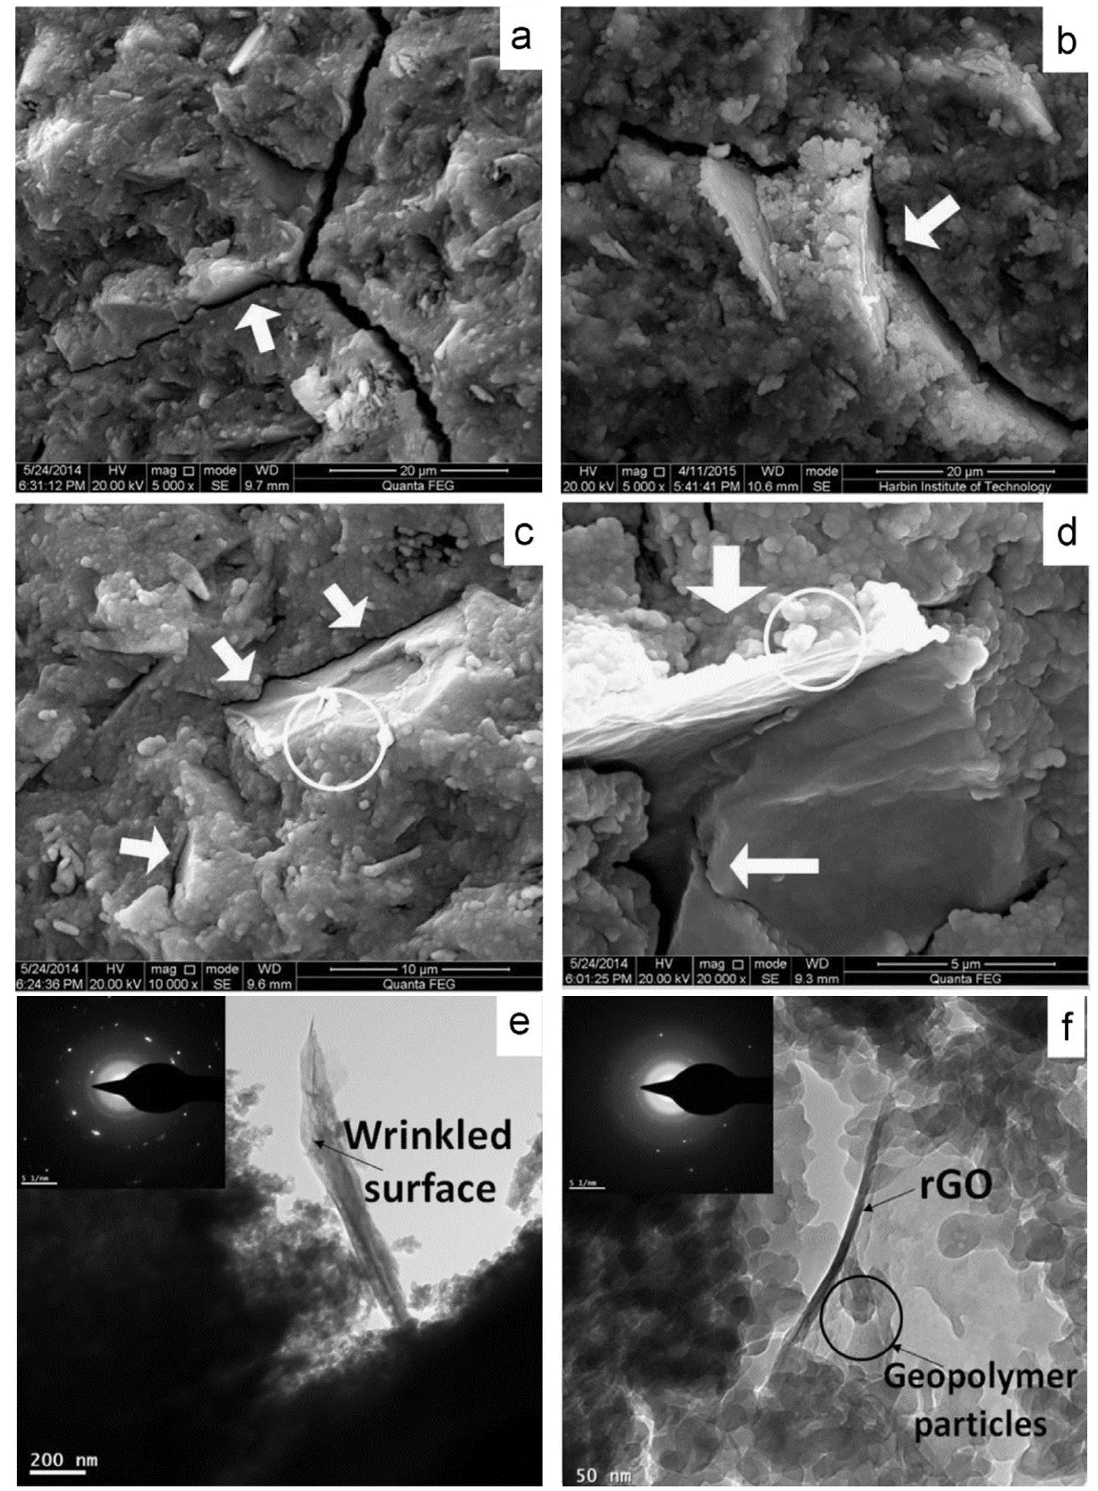
Figure 7: Detailed observation of interface microstructure of the rGO/GP5 composites: (a)–(d) SEM images; (e), (f) TEM images; insets display selected electronic diffraction patterns